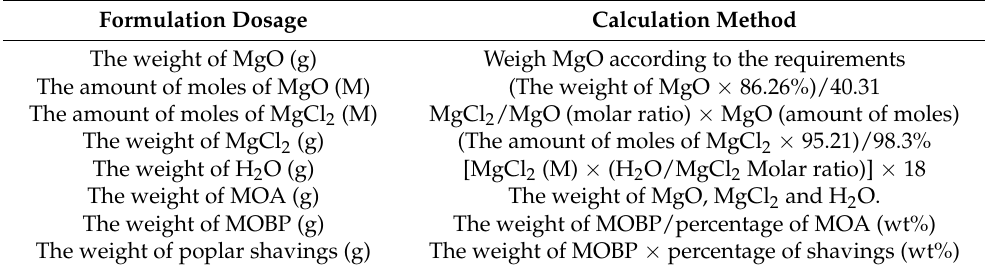
Table 2. Calculating methods of different raw materials.